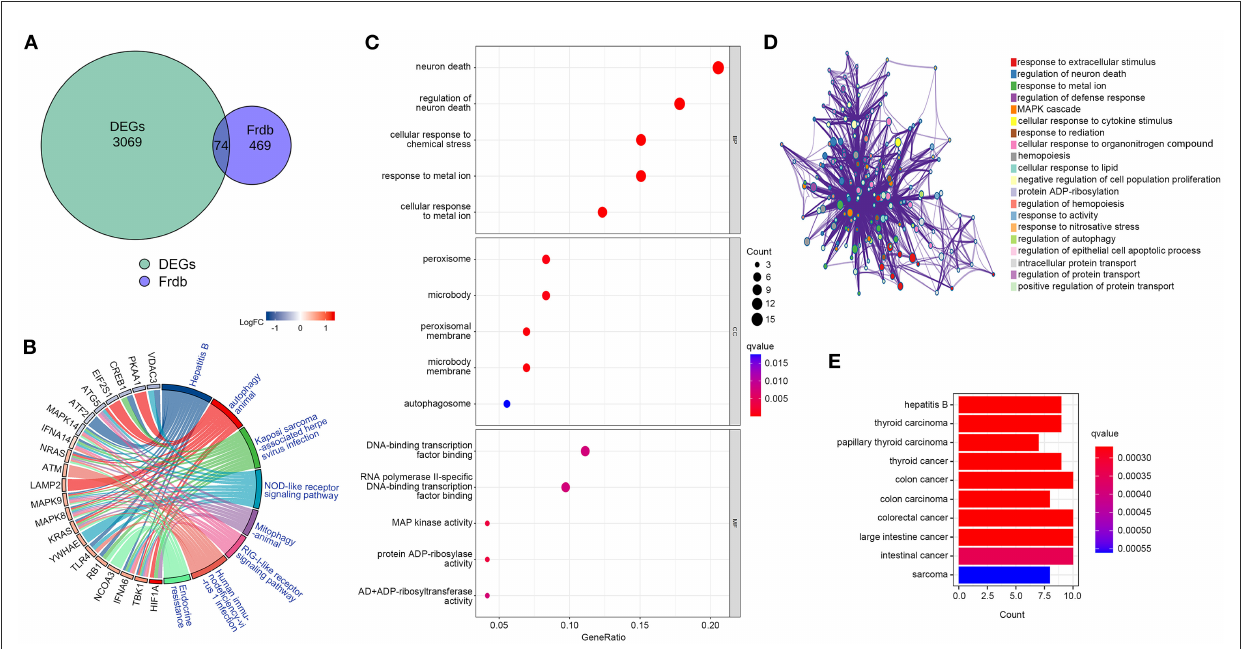
FIGURE3 Identification of f-DEGs,f-DEGs enrichment analysis. (A) 74 f-DEGs were obtained from the intersection of the FerrDb V2 database with DEGs. (B) KEGG pathway analysis of f-DEGs. (C) GO enrichment analysis f-DEGs. (D) GO term analysis on f-DEGs using the Metascape website. (E) Disease Ontology analysis of